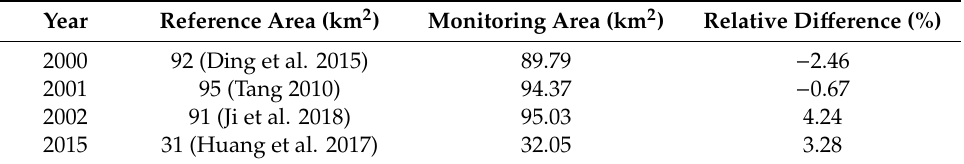
Table 2. Relative difference between the monitoring area of the pen aquaculture mapped using our approach and the reference areas.